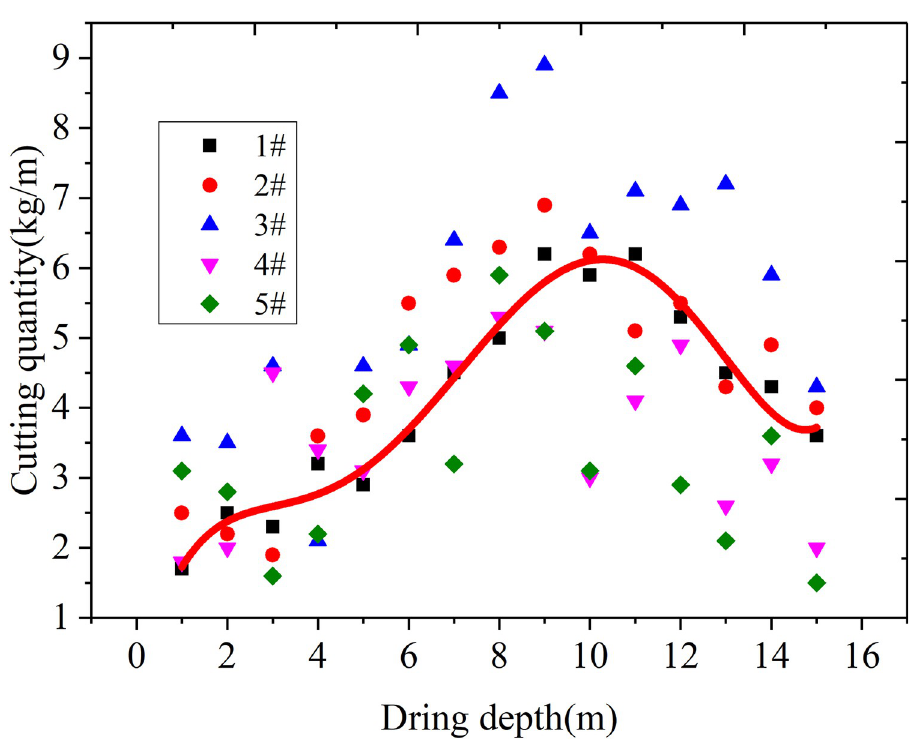
Fig 14. Relationship between the drilling depth and the cuttings quantity at the 10 selected sampling sites of the 23302 working face 1–5#.